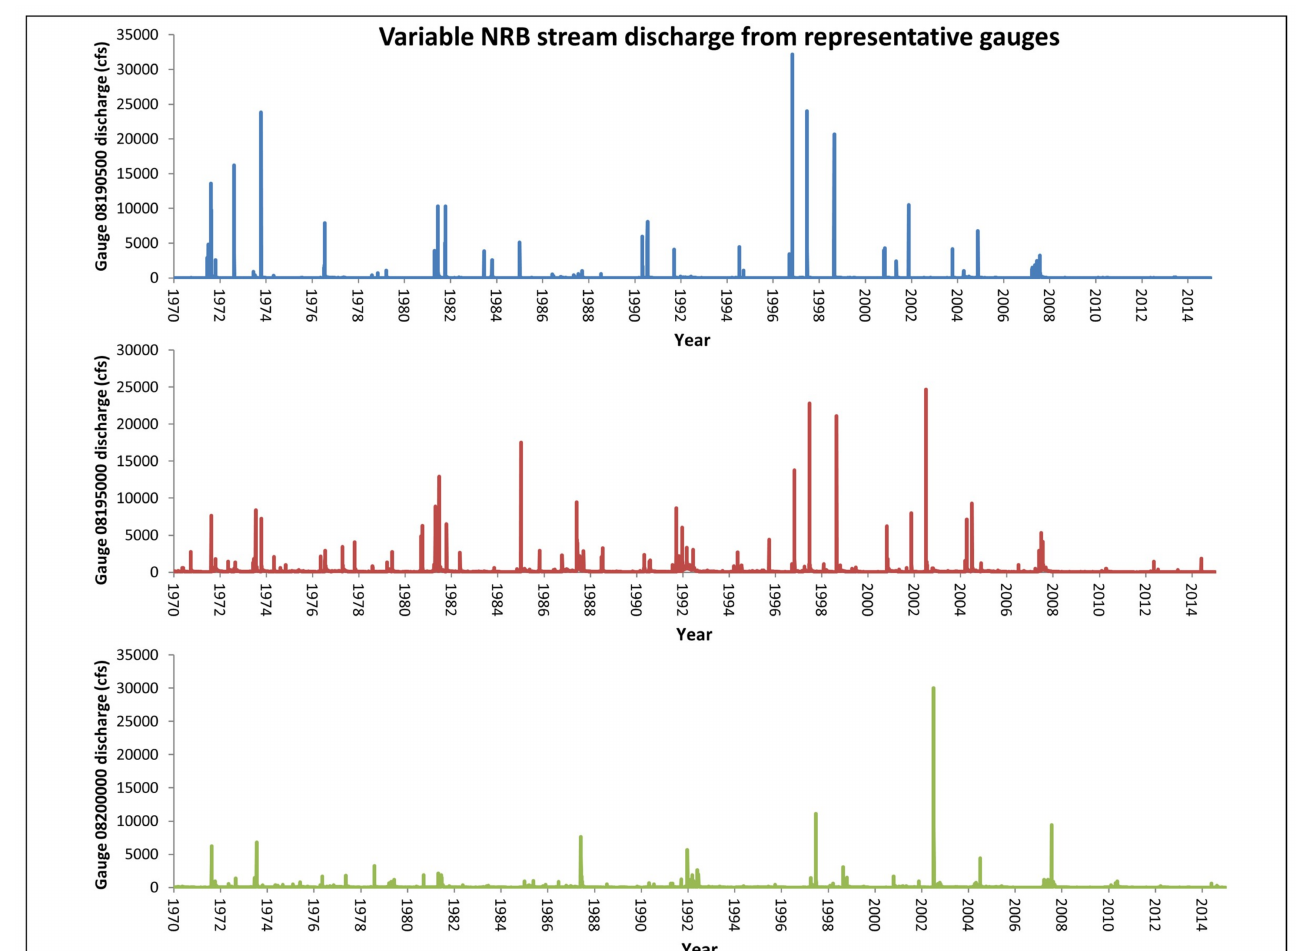
Figure 6. Streamflow from the most western (top), central (middle), and eastern (bottom) gauges in the